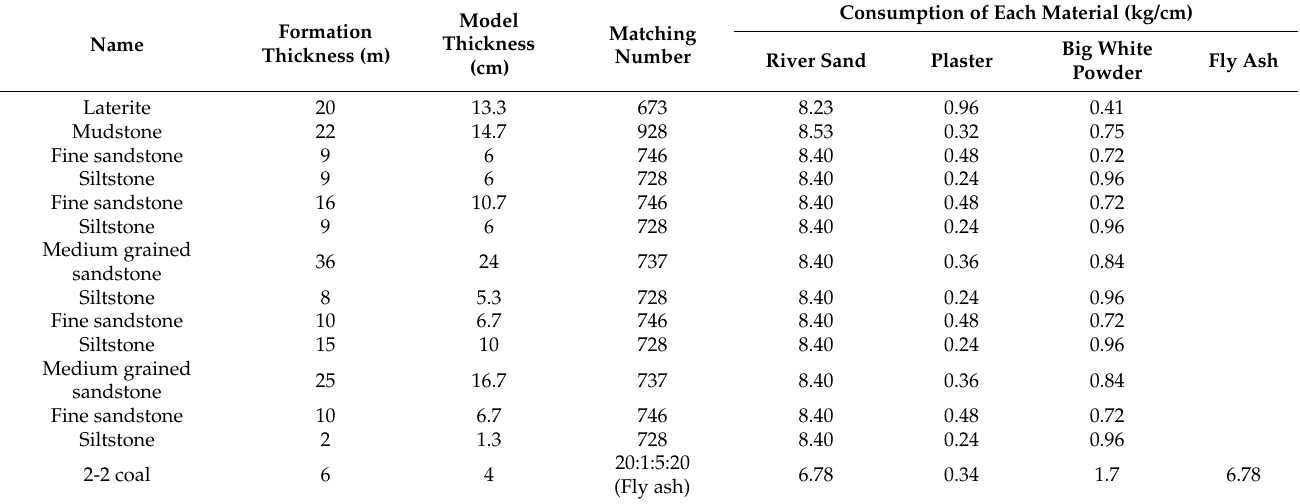
Table 3. Proportion of physically similar simulated materials